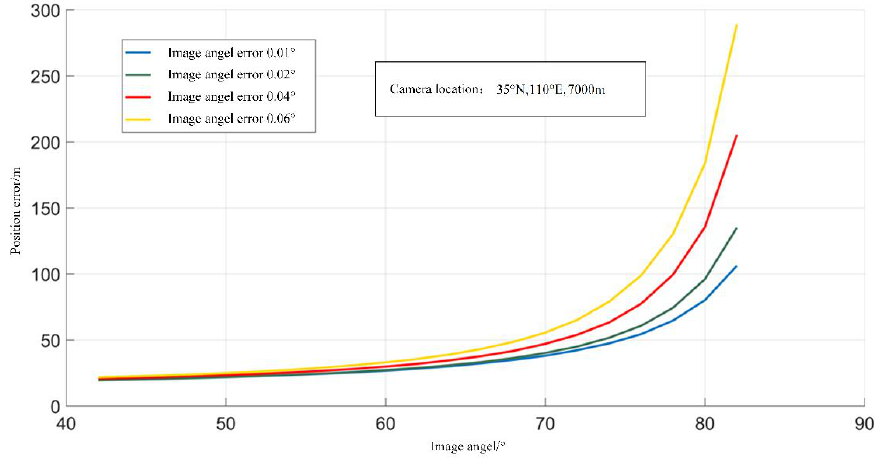
Figure 12. Positioning errors caused by imaging angle error.